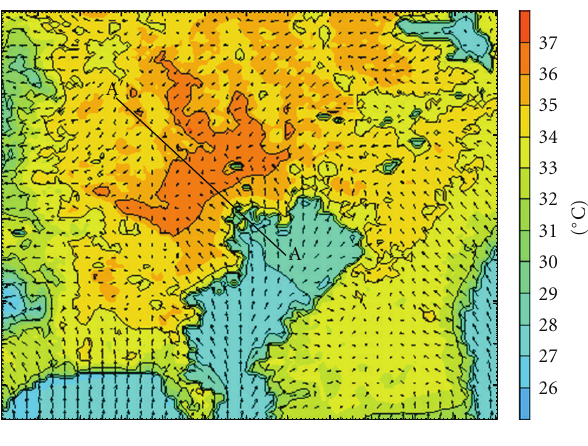
Figure 14: The CMAQ simulated O 3 in Domain 3 at 14:00 JST on August 4, 2005; the inner box (D4) is defined as the Tokyo area that was used to extract variables for statistical